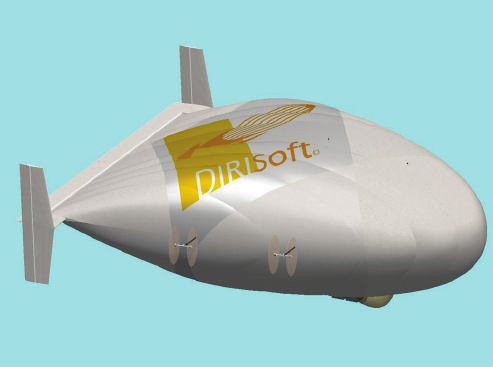
Figure 1: The flying wing Airship